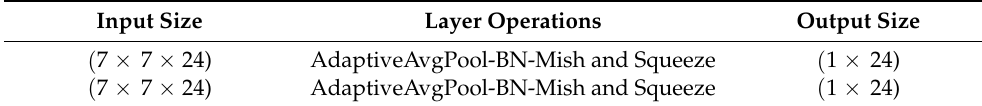
Table 5. Detailed steps of the feature fusion and classification